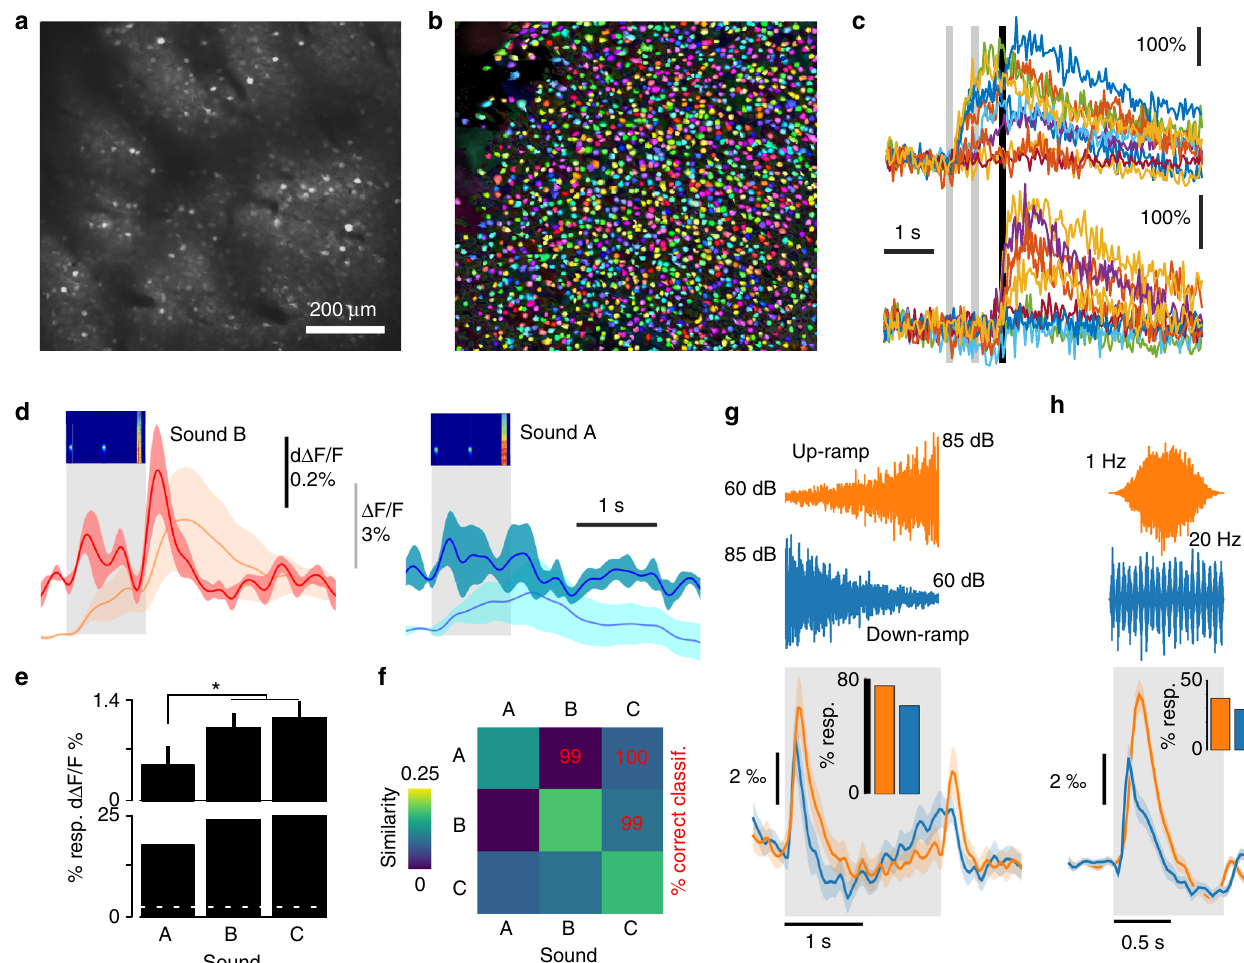
Fig. 2 Spectro-temporal differences impact on cortical recruitment. a Example fi eld of view illustrating GCAMP6s labeling of L2/3 auditory cortex neurons. b Result of automated cell segmentation run on the data acquired in the example shown in a . c Example single trial responses to sounds (different colors) for two neurons (top and bottom). Gray bars = sound duration. d Population responses ( n = 27 sessions, 15,511 neurons in 6 mice) to Sound B (red) and A (blue). Both normalized fl uorescence (light colors) and deconvolved (dark colors) calcium signals are shown. e Mean deconvolved signal and fraction